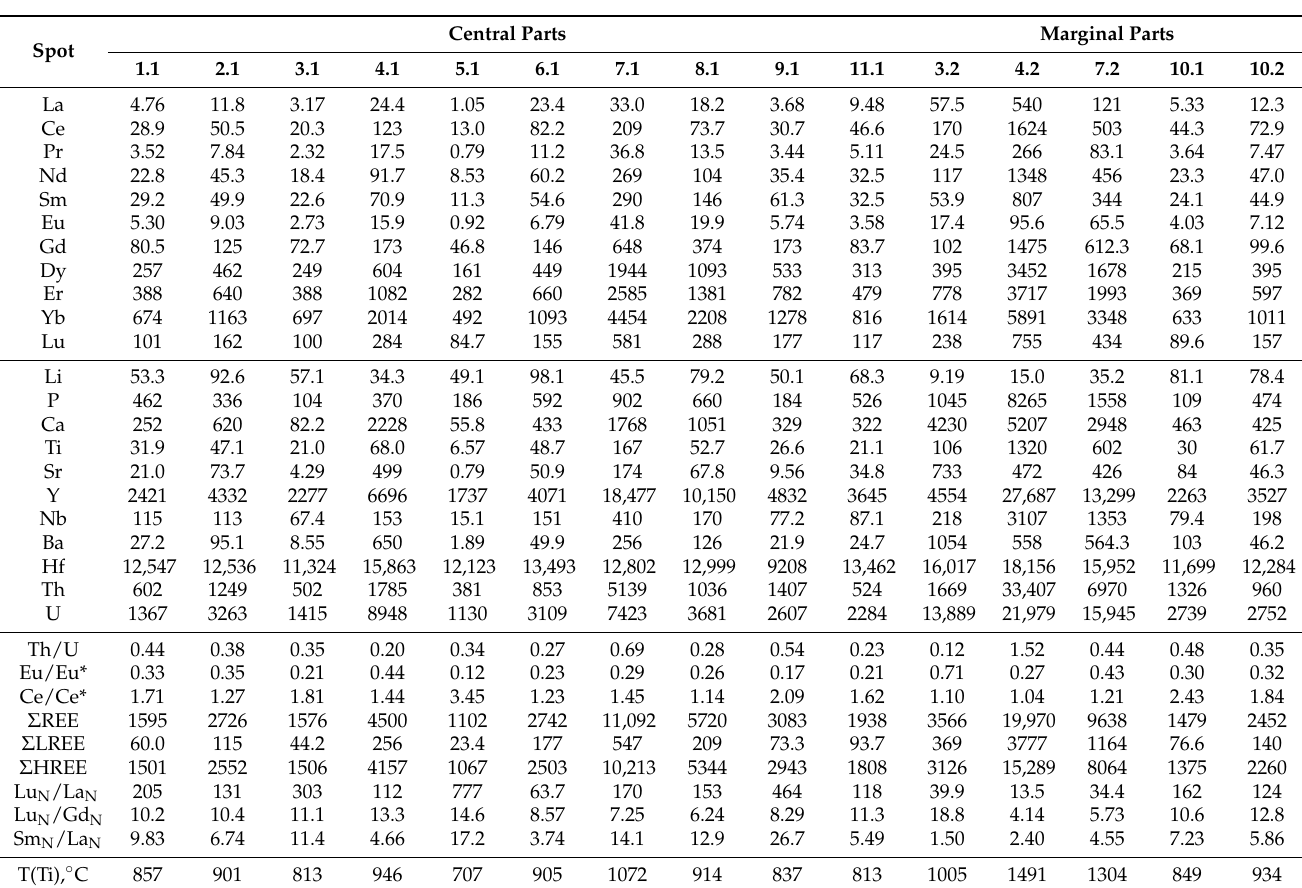
Table 2. Trace element concentrations (ppm) and the calculated temperature in zircons from the granites (sample DV-27/04). Spot